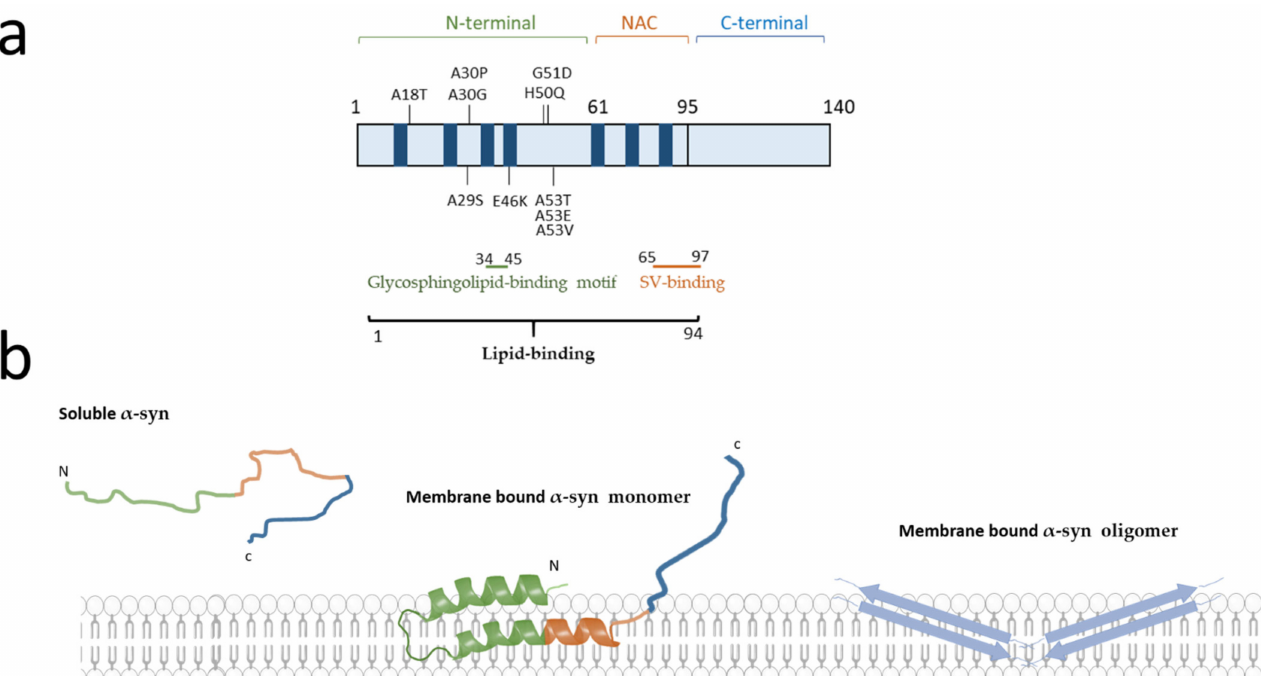
Figure 1. Schematic representation of α -synuclein ( α -syn) mutations and lipid binding regions. ( a ) Schematic represen- tation of the domain structure of α -syn. The α -syn is composed of three domains: the N-terminal domain (green), the NAC domain (orange) and the C-terminal domain (blue). Four confirmed pathogenic autosomal dominant missense mutations (A30P, G51D, A53E, A53T) as well as six putatively pathogenic mutations (A18T, A29S, A30G, E46K, H50Q, A53V) are depicted [11]. In blue are represented the seven KTKEGV hexameric repeats spanning from the N-terminus to the non-amyloid β -component (NAC) domain. The lipid binding regions are represented by lines of different colours (black = lipid binding, green = glycosphingolipid-binding motif and red = synaptic vesicles (SV)). ( b ) Schematic representa- tion of the different conformations of the α -syn. α -syn is present in the cytosol as unfolded monomer. Binding of α -syn to lipids induces a conformational change of α -syn N-terminal region, which acquires an α -helix secondary structure. The oligomers penetrate into the lipid bilayer with a β -sheet structure. The membrane image is adapted from Servier